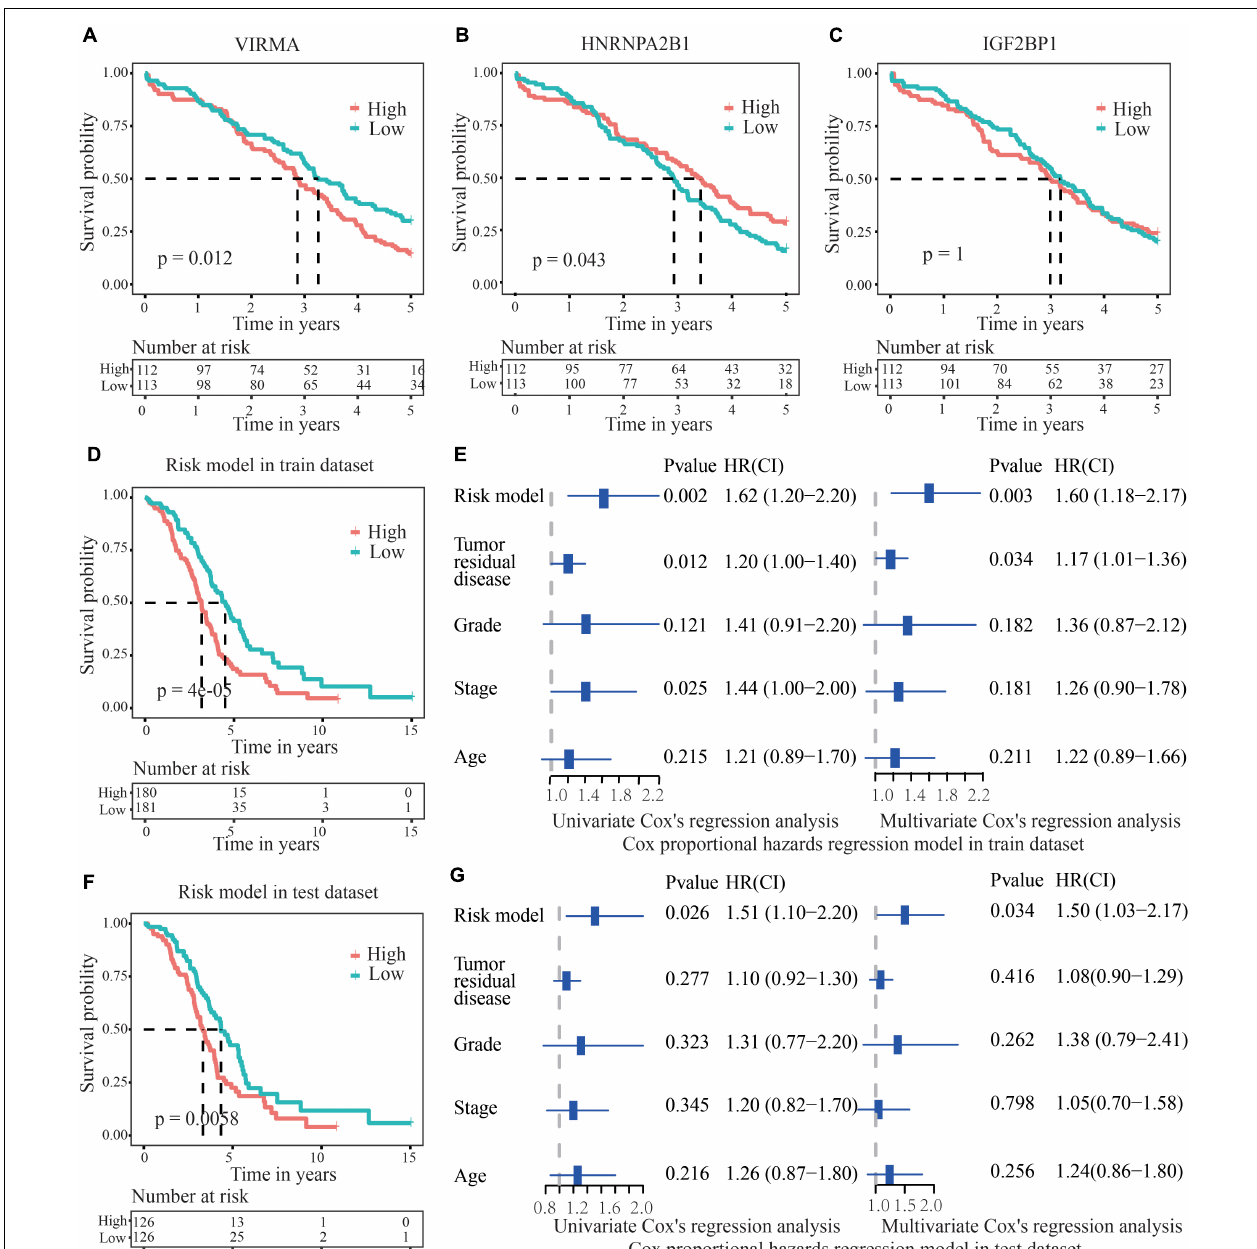
FIGURE 4 | Validation of the accuracy of the risk score model to predict the prognosis of patients with OC. (A,B) The survival time of OC patients with 50% survival rate presenting low VIRMA expression or high HNRNPA2B1 expression was longer than that of the controls. (C) IGF2BP1 expression was not related to the 5-year survival rate of patients with OC. (D) In the train dataset, the survival time of OC patients with 50% survival rate in the low-risk group were obviously longer than those of patients in the high-risk group. (E) Univariate and multivariate analyses of patients with OC were executed to appraise whether clinicopathological characteristics were independent prognostic factors of patient outcomes. The univariate analysis indicated that the risk score model, stage and tumor residual disease were all independent factors predicting a poor prognosis for patients with OC. (F) In the test dataset, the survival time of OC patients with 50% survival rate in the low-risk group were also longer than those of patients in the high-risk group. (G) In the test dataset, the univariate analysis demonstrated that the risk model was also an independent factor predicting a poor prognosis for OC patients, which is consistent with the results from the train